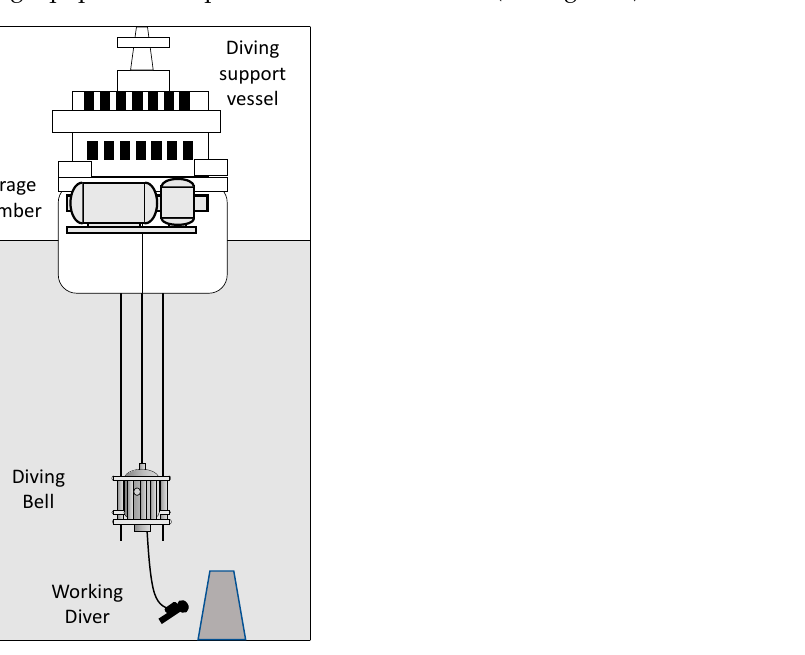
Figure 1. A typical saturation worksite. The divers are deployed from the diving support vessel inside a diving bell. Once on site, the bell’s door opens, and the divers lock out in the water using an umbilical attached to the bell to breathe and being supplied with hot water in their suit for thermal comfort. The working depth corresponds to the maximum depth reached by the divers. The working depth defines the chamber storage depth from excursion tables prepared in the company diving manual. The bell depth is usually set at 5 msw deeper than the storage depth to clear from subsea structures when opened. The “storage” and the “bell” are almost at the same pressure allowing for getting back to storage after work without decompression needed. The excursion of the diver out of the diving bell is limited to some meters not to add additional decompression time. The breathing gas is Heliox (Helium-Oxygen) to limit the density of the breathed gas (significant at such pressures) to reduce the work of breathing as well as Oxygen toxicity and Nitrogen narcosis.